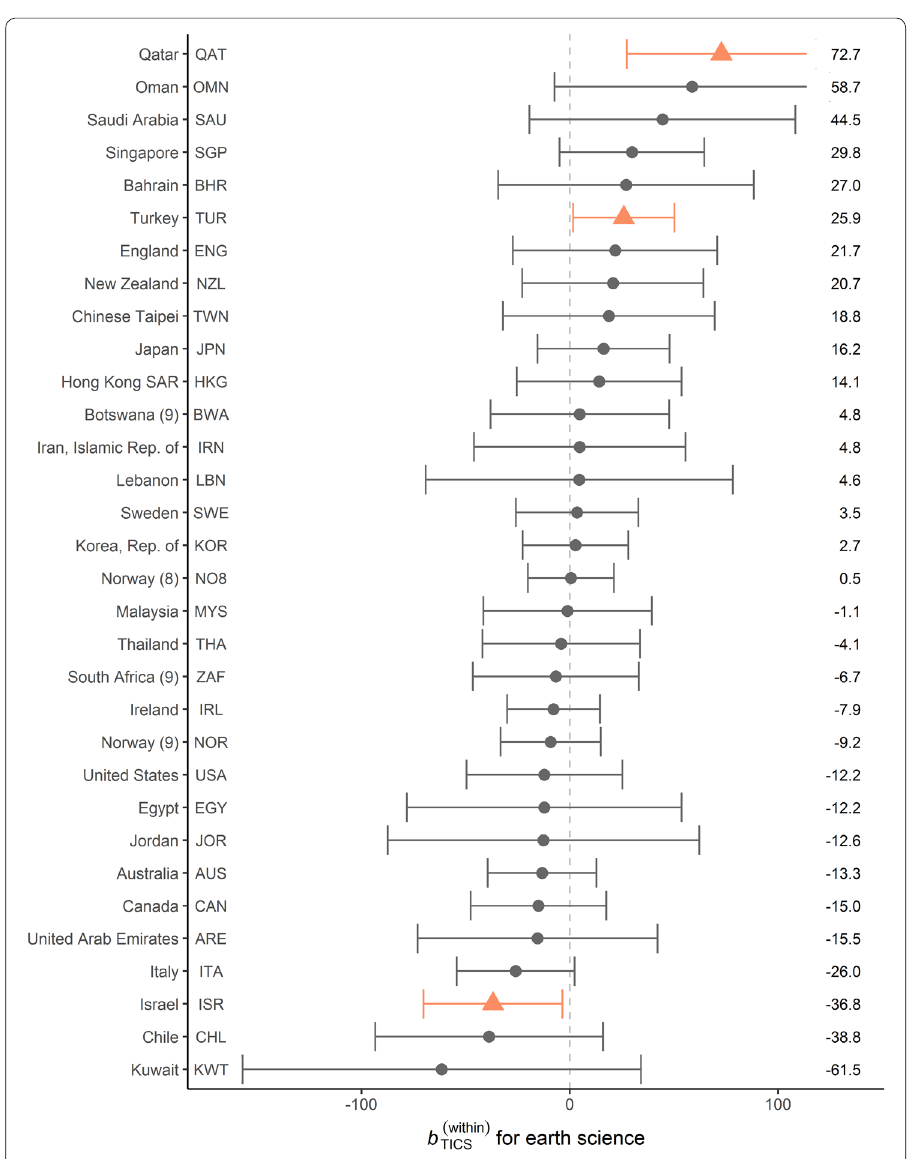
Fig. 12 Forest plot of the slope estimate in earth science with 95% CI for TICS on achievement by